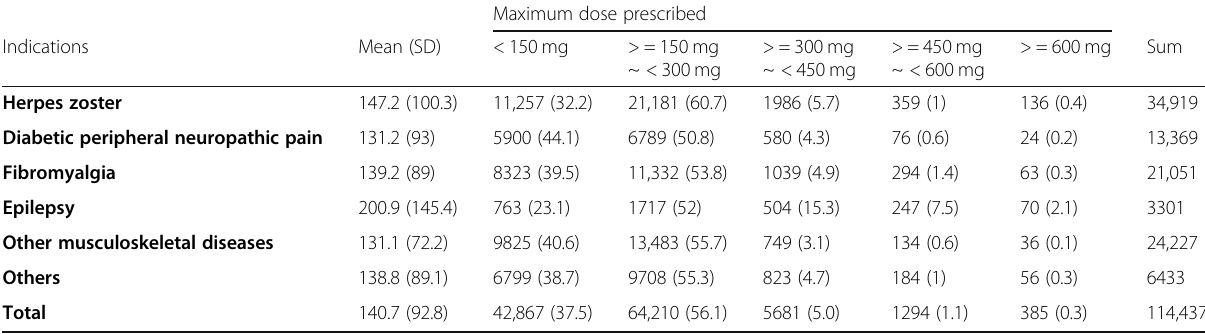
Table 3 Proportion of prescribed maximum daily dose of pregabalin during follow-up